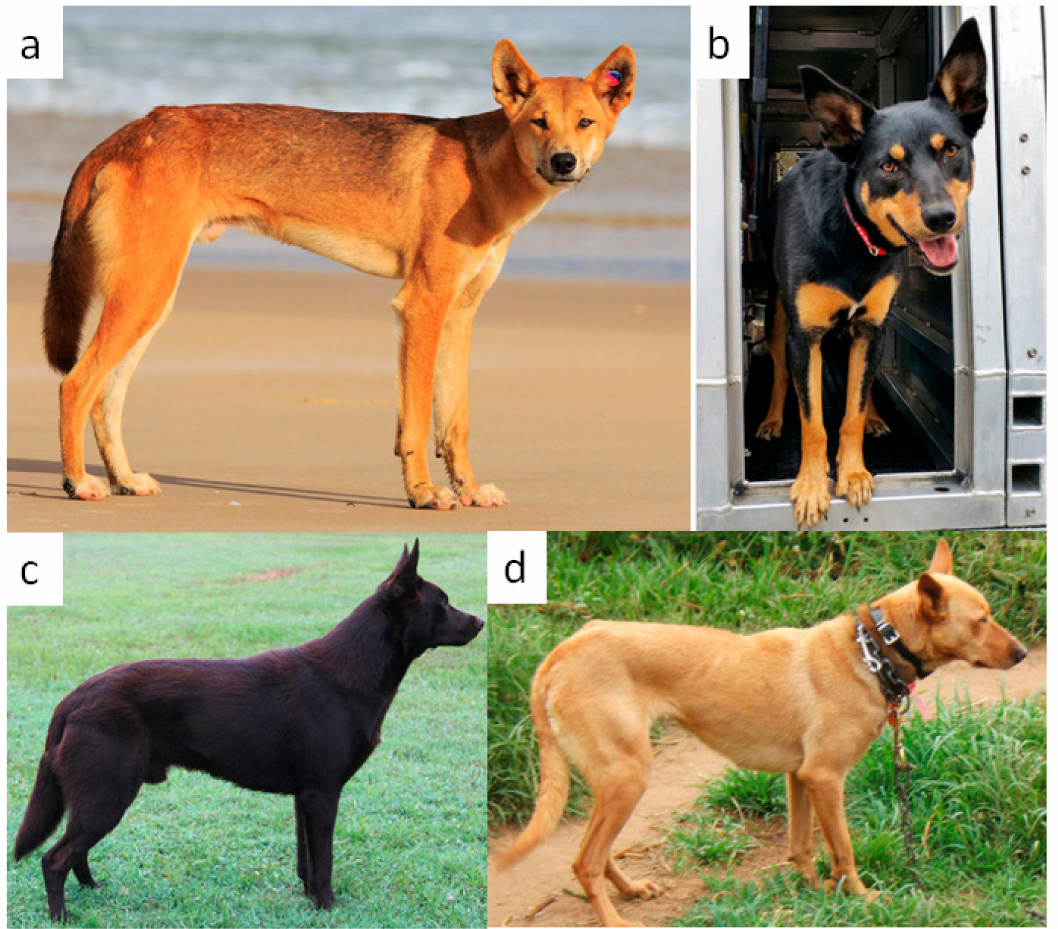
Figure 1. ( a ) Australian Dingo ( Canis dingo ), Fraser Island (image: IStockPhoto.com). ( b ) Australian Working Kelpie demonstrating tan patterning (image: Al Dodge Photography). ( c ) Australian Kelpie (image: Mandy Samson). ( d ) Ginger / Cream Australian Working Kelpie (image: Janelle